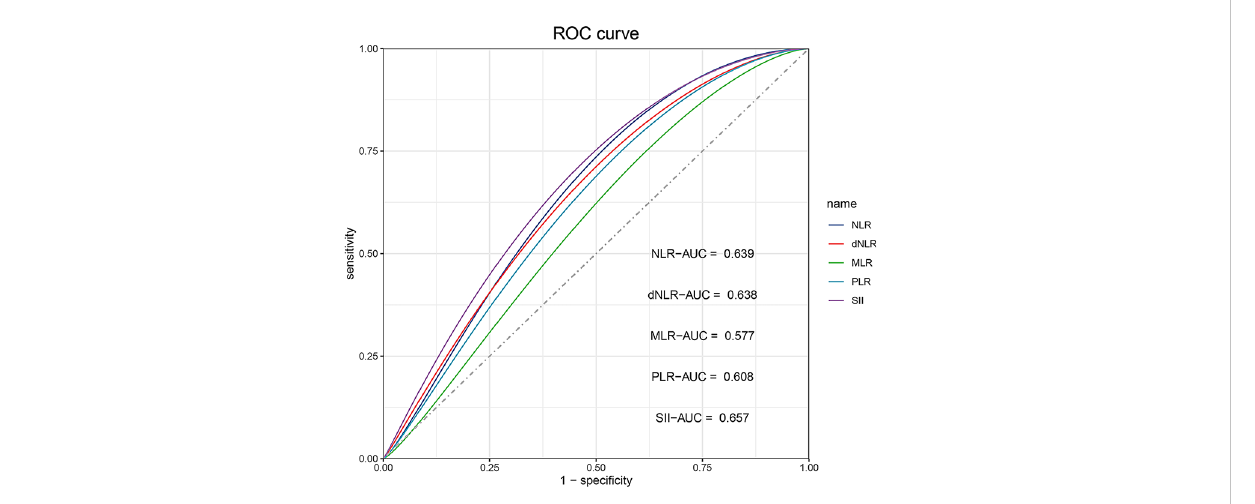
FIGURE 2 The ROC curve analysis for cut-off values of NLR, dNLR, MLR, PLR, and SII, respectively. The areas under the ROC curve of NLR, dNLR, MLR, PLR, and SII are indicated.